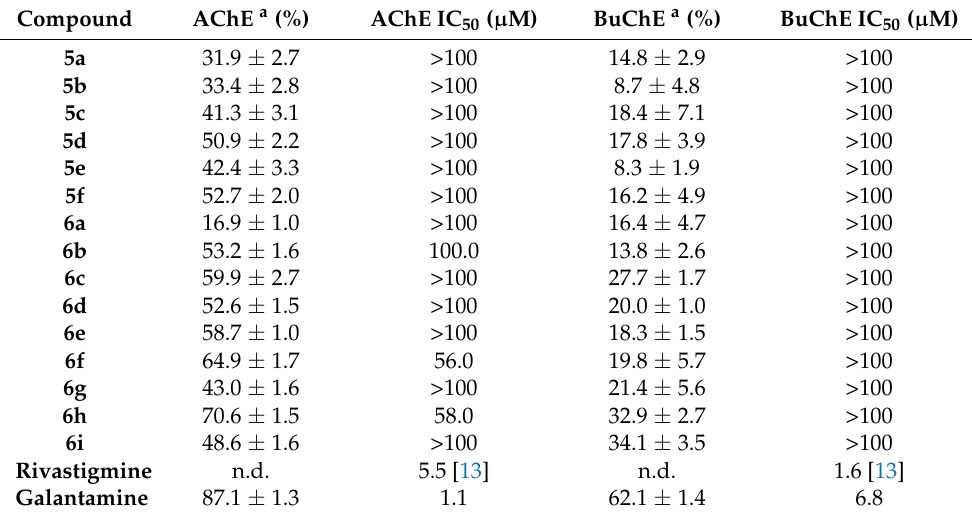
Table 2. The ability of compounds to inhibit AChE and